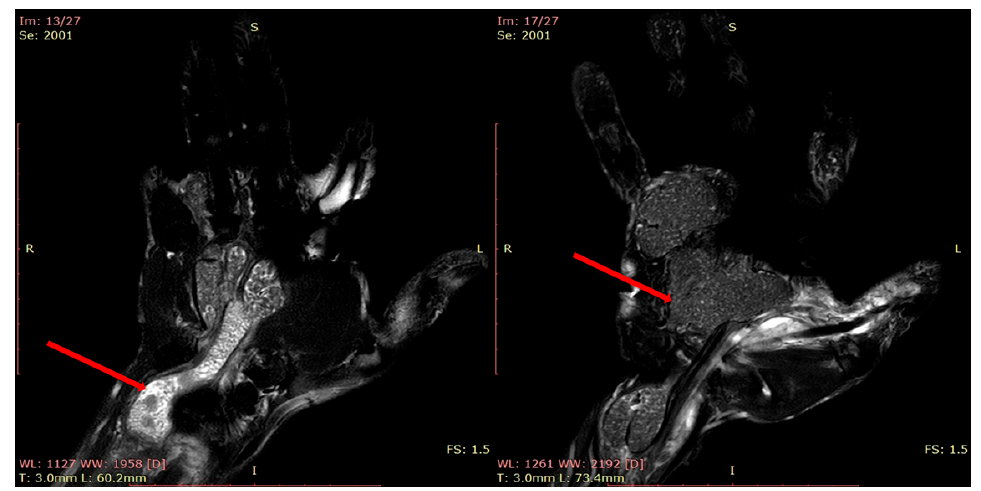
Figure 13. Idiopathic tenosynovitis with “rice bodies”—MRI aspect . In all cases, the complete removal of the pseudotumors was performed under an axillary block (Figure 14).